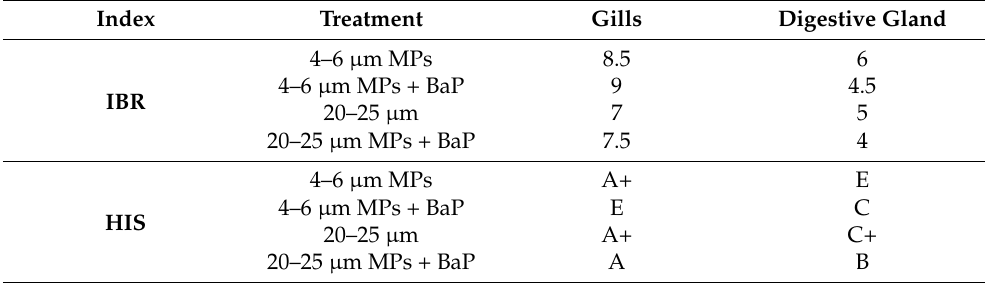
Table 3. IBR and HIS in the gills and digestive glands for all treatments. A (Healthy); B (Low Stress); C (Medium Stress); E